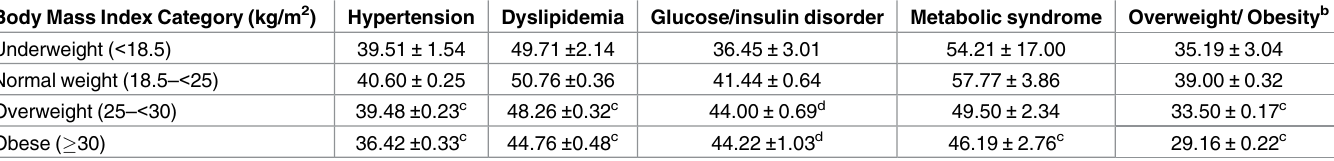
a Time to diagnosis is expressed as mean adjusted time in months (standard error). Means were adjusted for age at accession, sex, and year of accession.